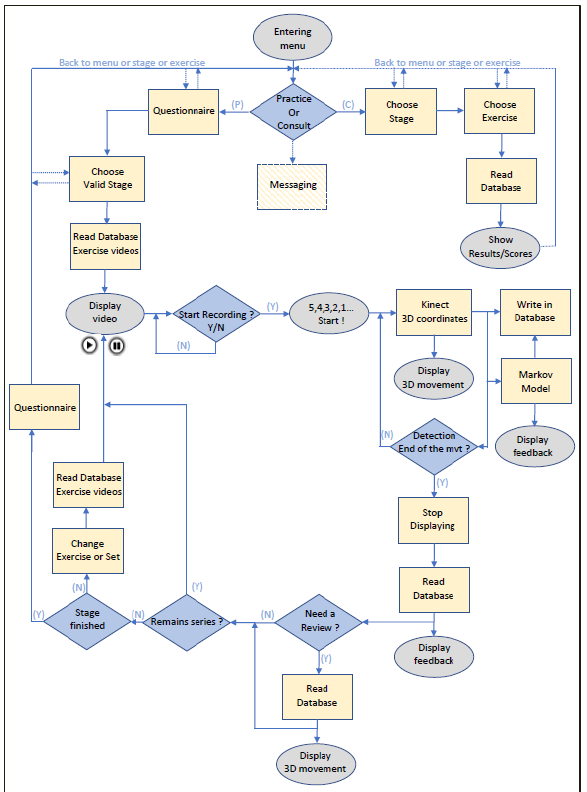
Figure 3 | Flowchart of the patient’s account.